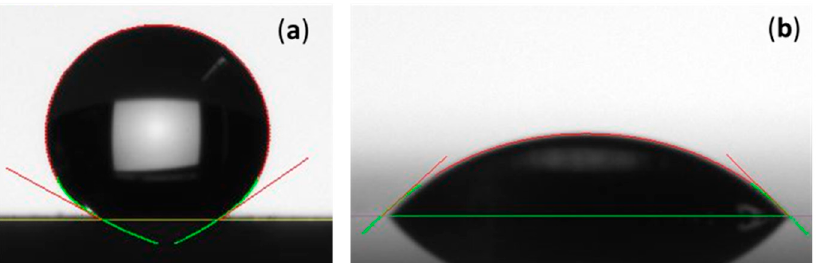
Figure 7. Contact angles of ( a ) water with superhydrophobic 2 (>150°) and ( b ) Ref. Fluid neat with aluminum (50°).